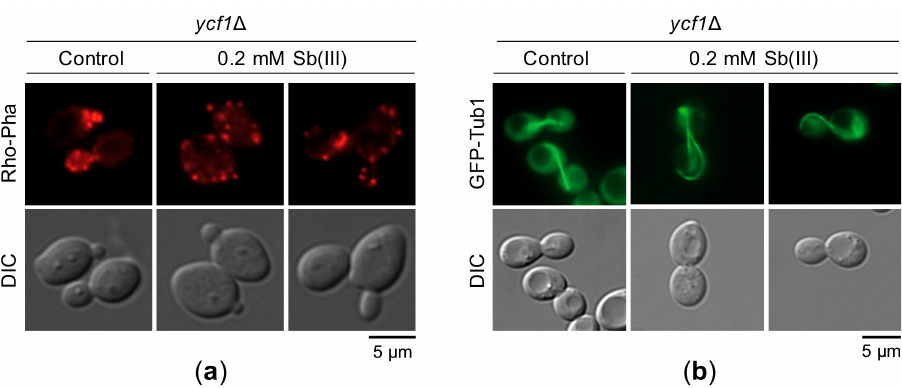
Figure 11. Sb(III) targets actin and microtubule cytoskeleton. ( a ) Exponentially growing ycf1 ∆ cells were exposed to 0.2 mM Sb(III) for 2 h or left untreated and then chemically fixed for actin staining with rhodamine-phalloidin. ( b ) The ycf1 ∆ mutant expressing chromosomally encoded α -tubulin fused to GFP (GFP-Tub1) was grown to log phase and then treated with 0.2 mM Sb(III) for 2 h or mock-treated. Next, viable cells were analyzed by fluorescence microscopy to visualize microtubules. Scale bars: 5 µ